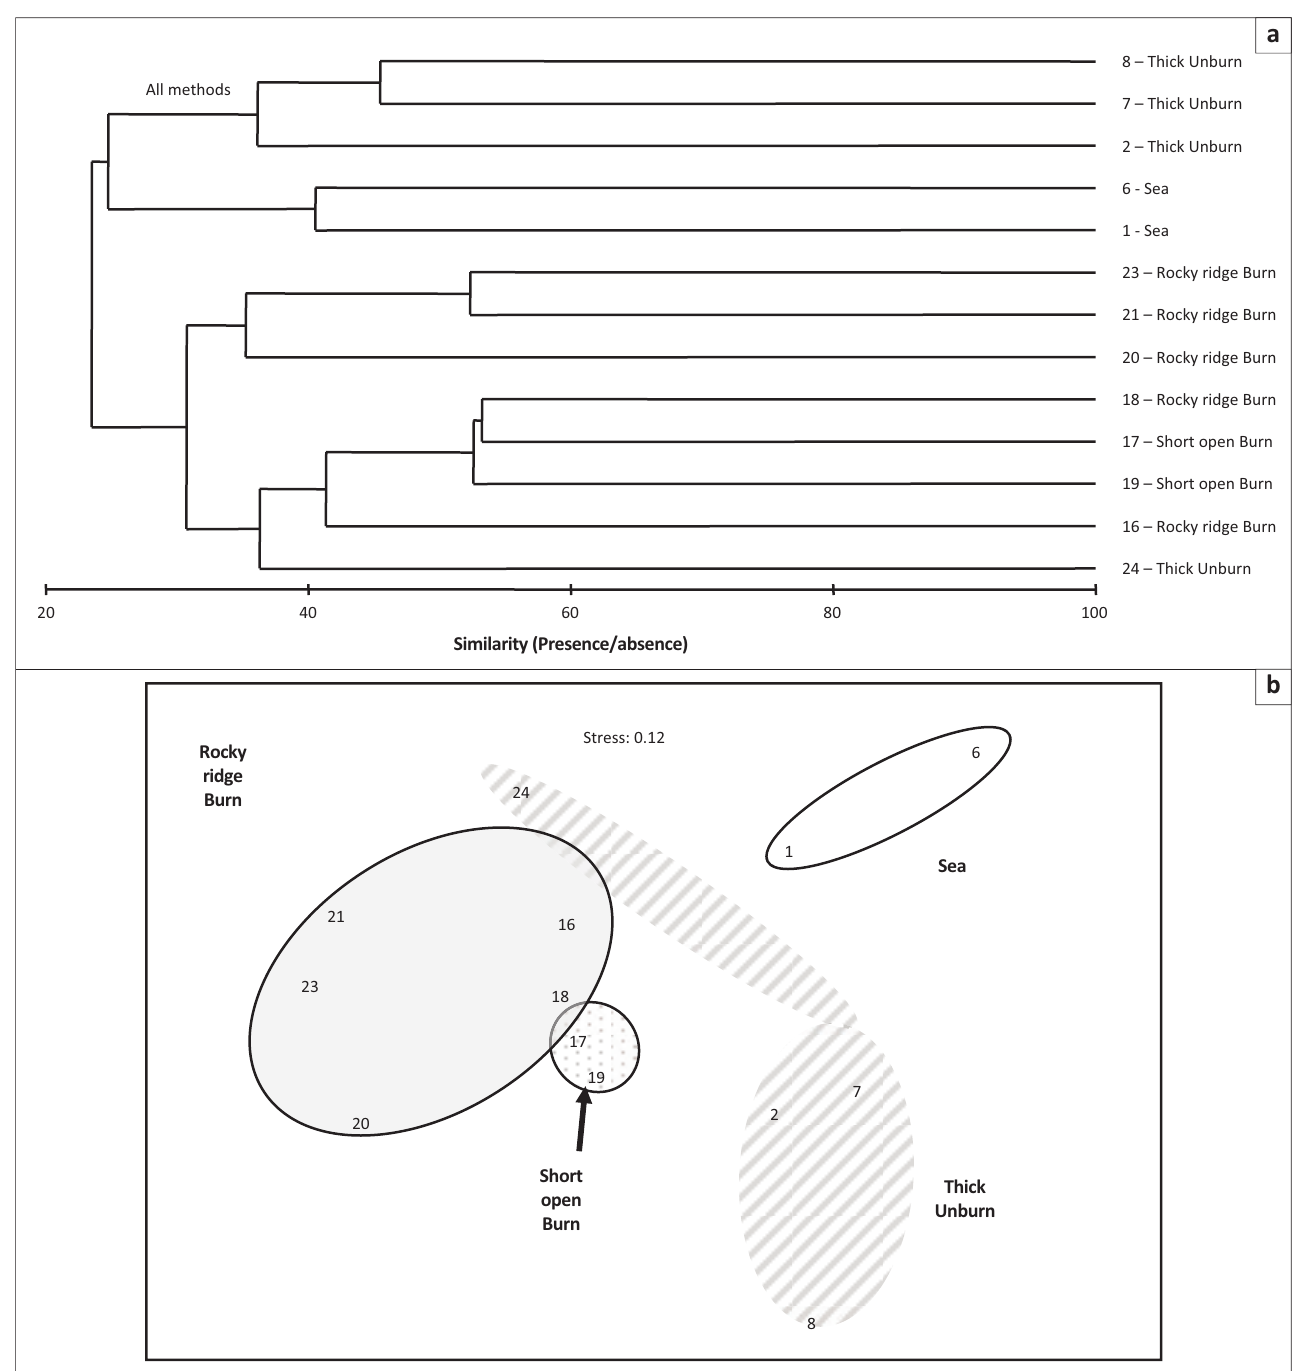
FIGURE 5: Community relationships among grassland sites at Mkambati based on those sites at which all sampling methods were used. (a) Similarity analysis and (b) multi-dimensional scaling